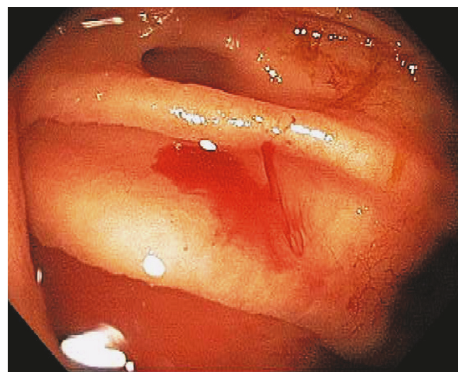
Figure 15: Endoscopic image of a bleeding angioectasia. Fresh blood oozes from a punctate